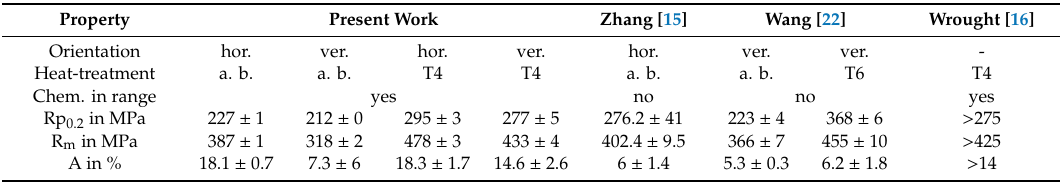
Table 6. Results from mechanical